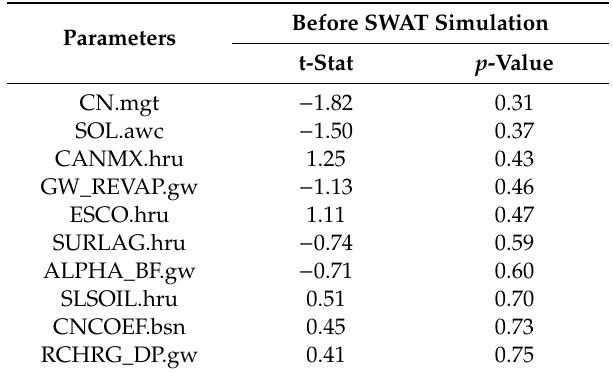
Table 4. Sensitivity analysis of SWAT model parameters before the calibration and validation process and for the final